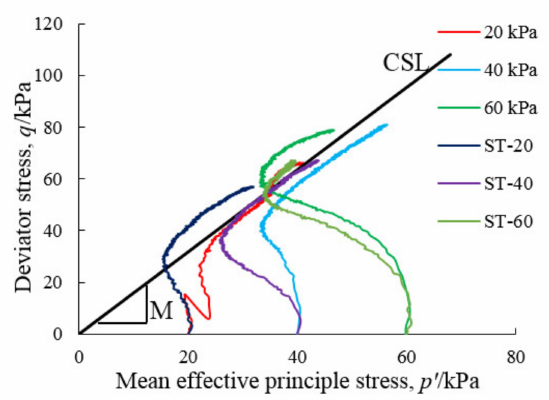
Figure 12. Effective stress paths of the soft soil at different confining pressures ( n = 1000, CSR = 0.25, U r =